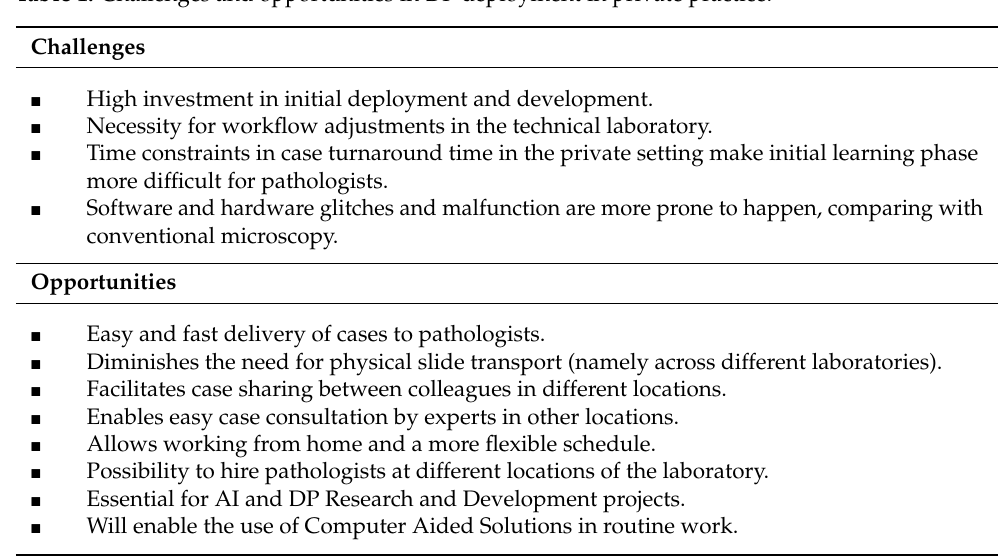
Table 1. Challenges and opportunities in DP deployment in private